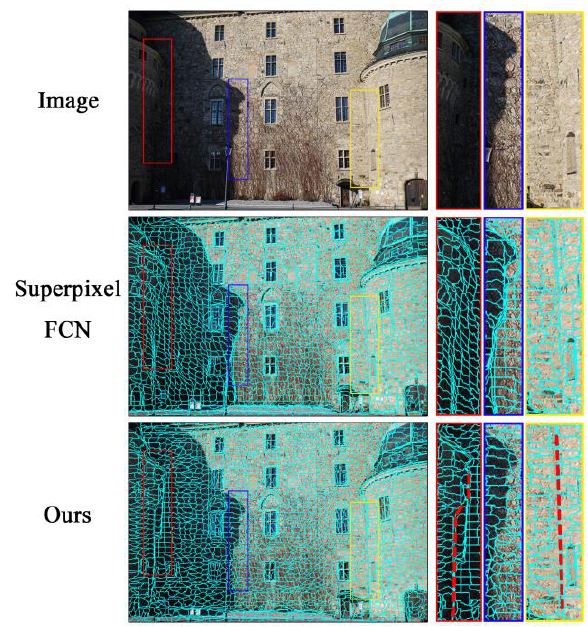
Figure 11 . Comparison of the results for superpixel segmentation method on building with shadow coverage.